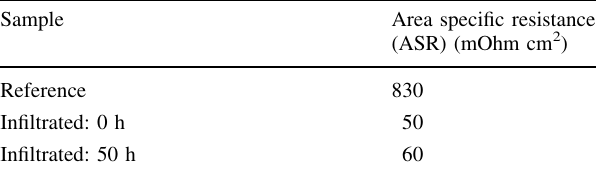
Fig. 8 Nyquist plots for symmetric anode cells tested at 600 (cid:3) C. The size of the arc indicates the magnitude of the polarisation losses. The infiltrated cell showed much lower polarisation losses than the reference both before and after 50 h aging Table 2 Area specific resistances of the symmetric